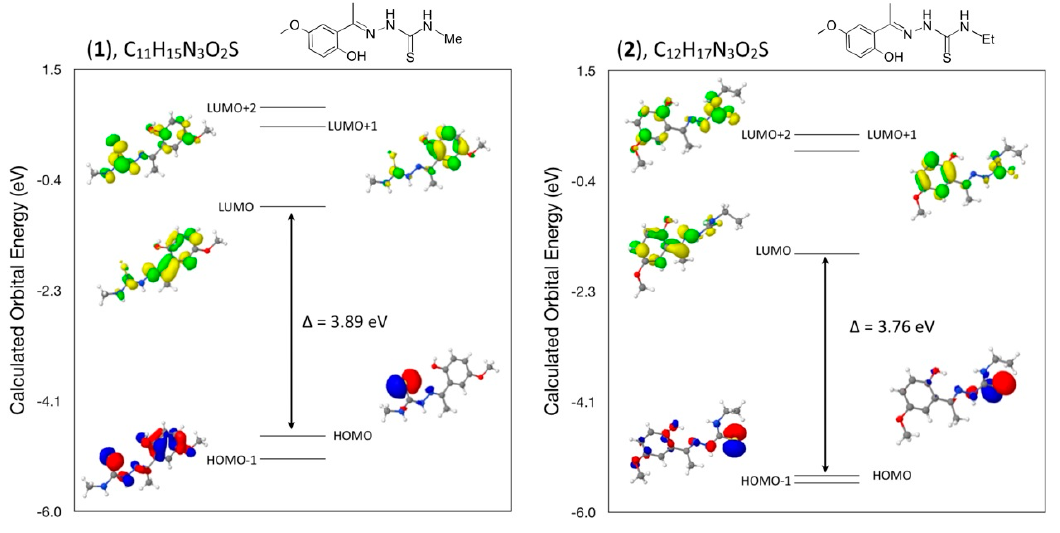
Figure 7. Calculated frontier molecular orbitals for C 11 H 15 N 3 O 2 S ( 1 ) and C 12 H 17 N 3 O 2 S ( 2 ). Table 7. Experimental and calculated energy of molecular orbitals of ( 1 ) and ( 2 ) and associated transitions.